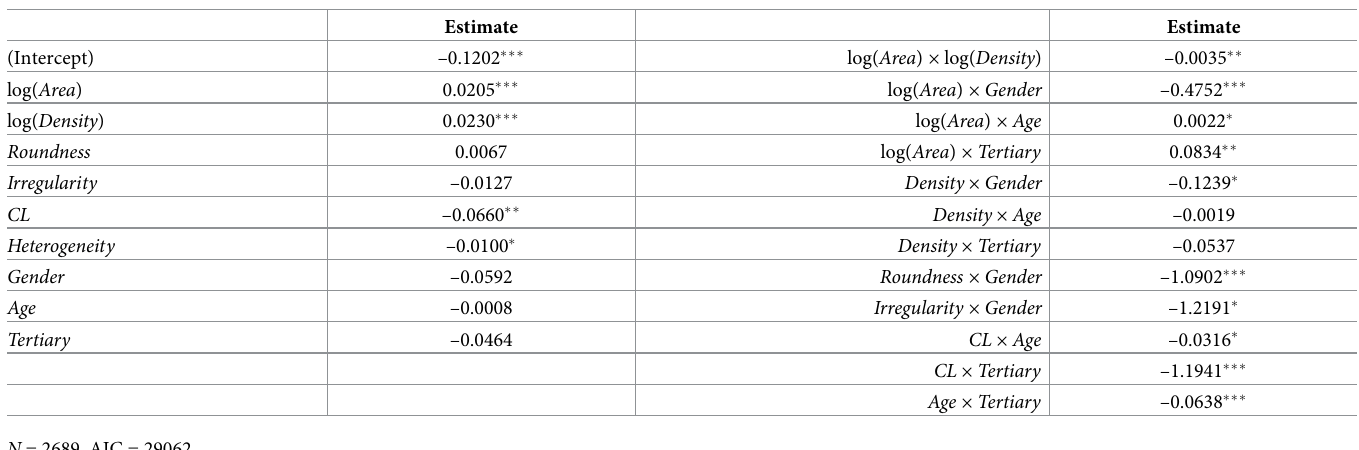
Table 6. The selected model.